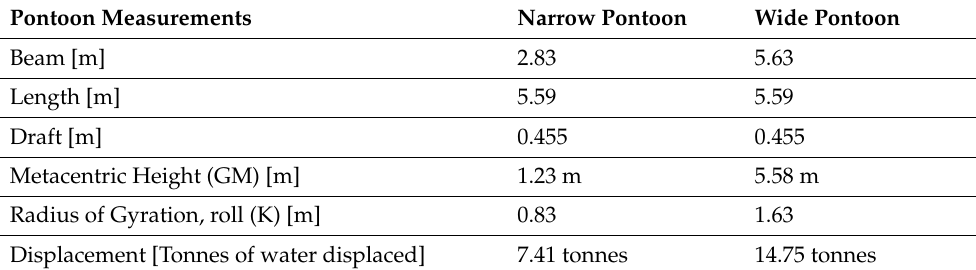
Table 2. Physical characteristics of the two pontoons tested. All values provided in prototype. Pontoon Measurements